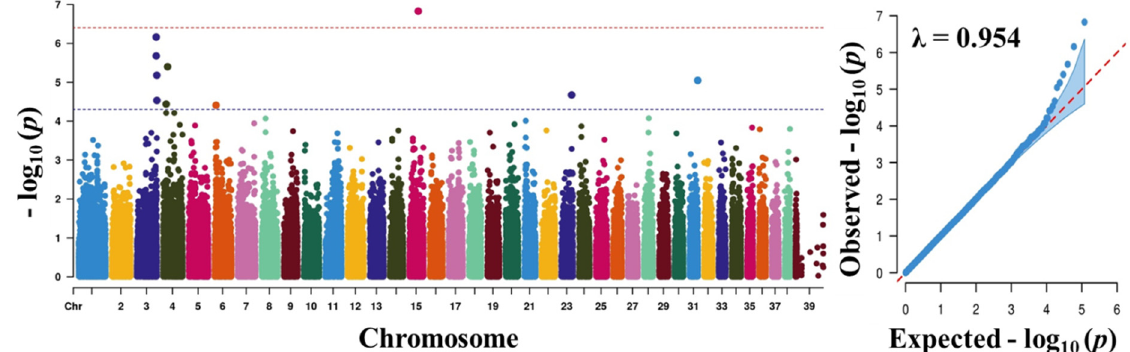
Figure 3. Manhattan plots of mapped single nucleotide polymorphism (SNP) markers associating with height. Red line designates the Bonferroni-corrected significance threshold level of p < 4 × 10 − 7 and blue line shows genome wide significant threshold level of p < 5 × 10 − 5 . The quantile-quantile (Q-Q) plot of the GWAS is shown in the right side. GWAS, genome-wide association study.